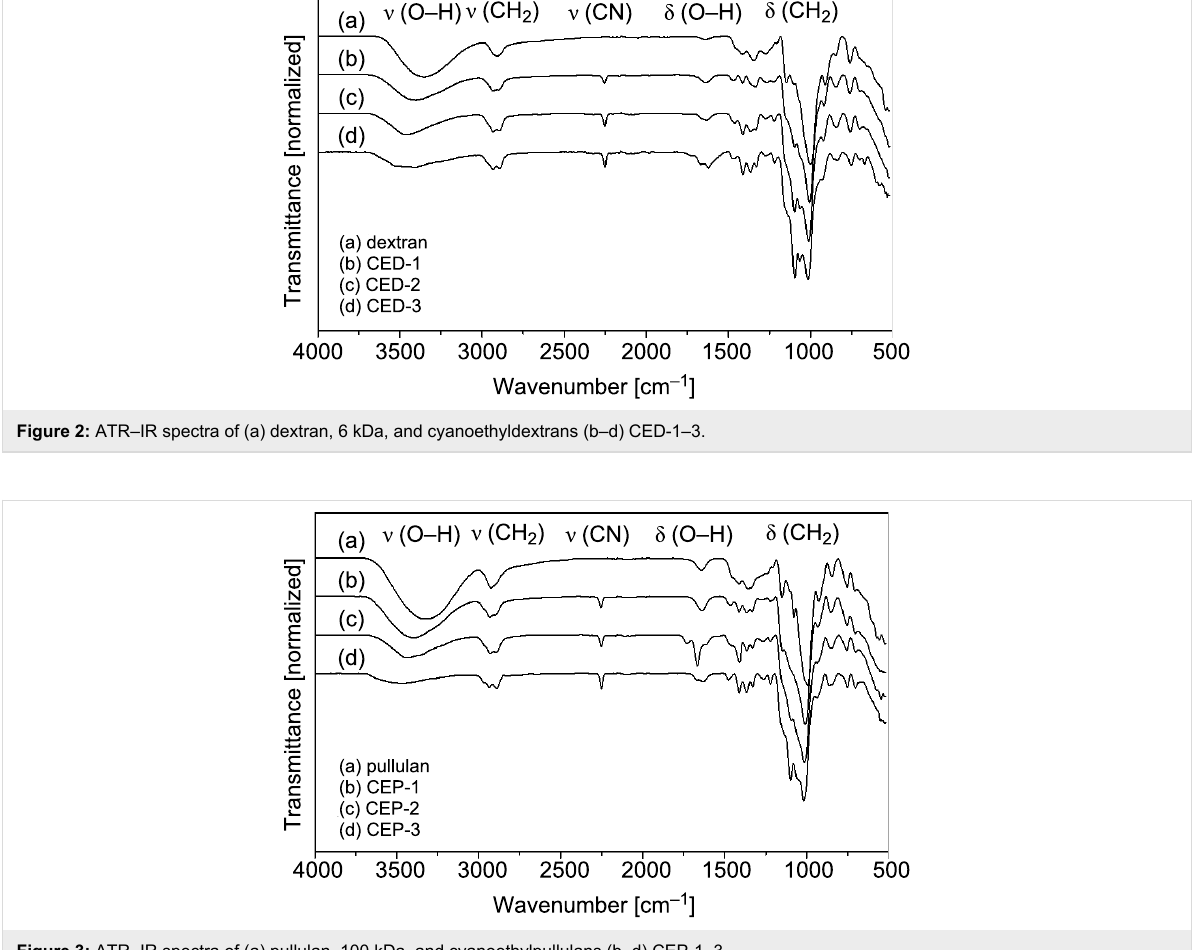
Figure 3: ATR–IR spectra of (a) pullulan, 100 kDa, and cyanoethylpullulans (b–d)